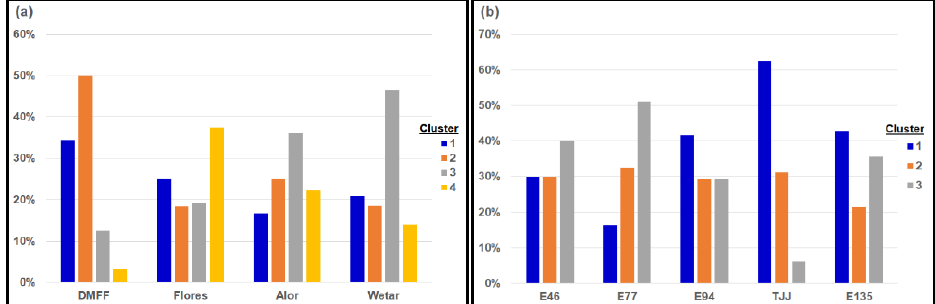
Figure 4. Proportions from each source group belonging to genetically homogenous clusters, determined by Bayesian cluster analyses with number of clusters determined by methods of Evanno et al. [34], for: ( a ) the first cycle population (presented by source groups comprising island/country of origin); and, ( b ) the third cycle population (presented by source groups comprising field trials of origin) of E. urophylla . Categories on X-axes represent geographic origins (parent locations), and these are for: ( a ) DMFF = Dongmen Forest Farm, China; Flores = Flores Island, Indonesia; Alor = Alor Island, Indonesia; Wetar = Wetar Island, Indonesia; for ( b ) E46, E77, E94 and TJJ are first cycle family trials, and E135 is the second cycle family trial.